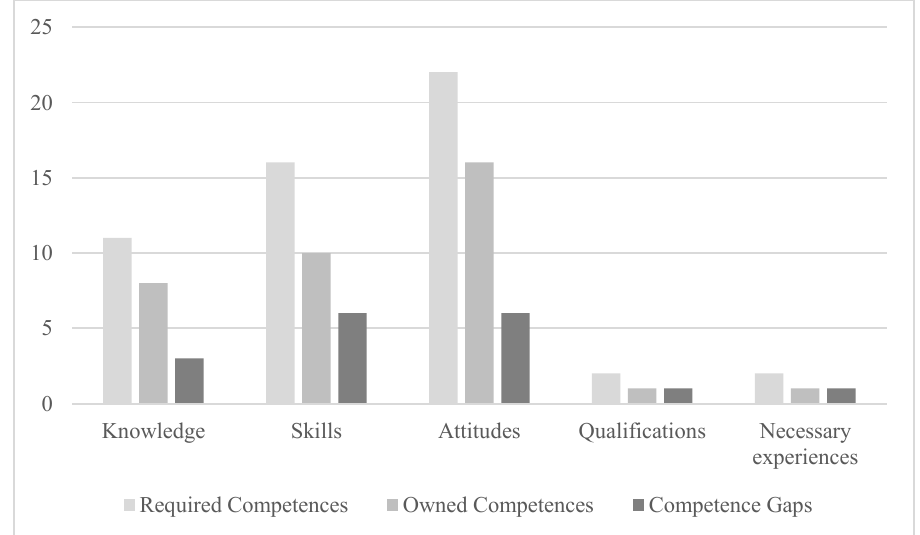
Figure 5. Administration manager role: histogram of results